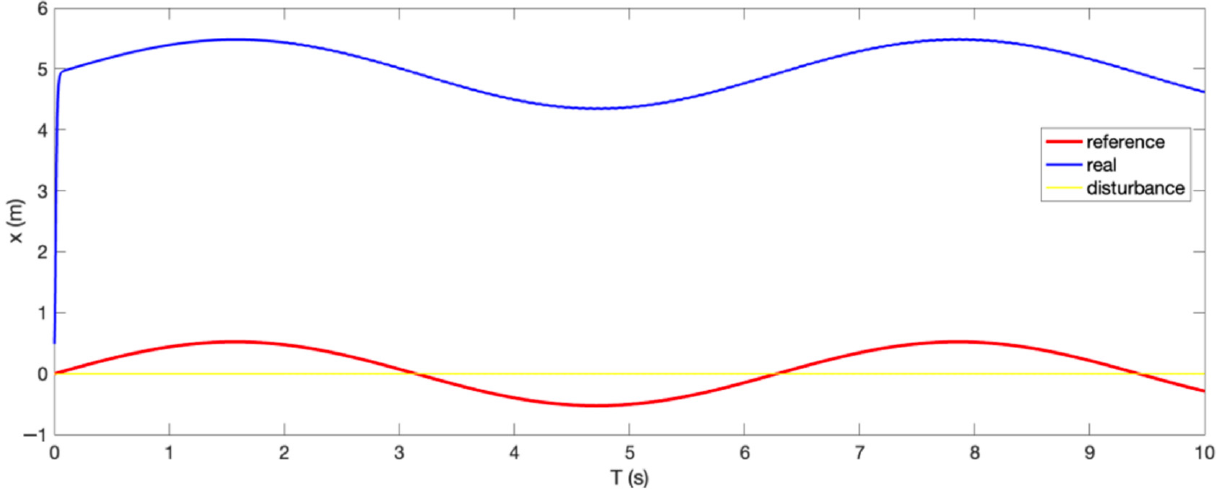
Figure 18. The reference trajectory (red cure) and the system response (blue curve) of the backrest posture control without RBFNN approximation with disturbance (yellow curve).